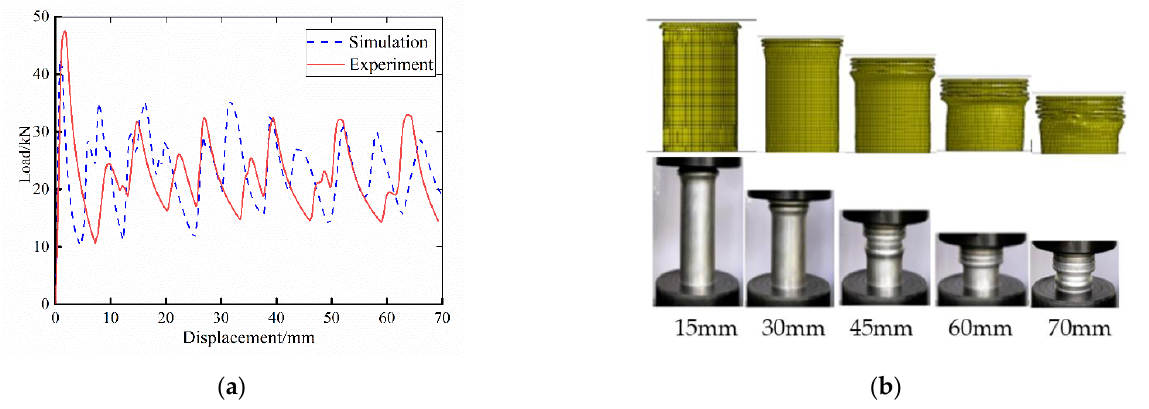
Figure 7. Simulation and experiment comparison of the Al tube: ( a ) load–displacement curve; ( b ) comparison of deformation modes.